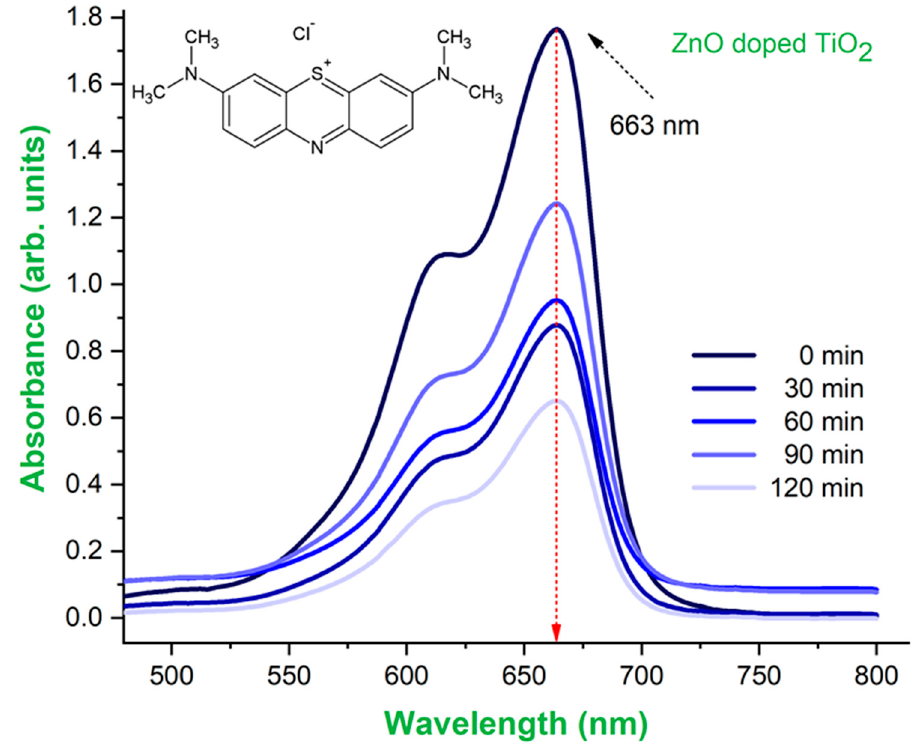
Figure 7. As a result of ZnO-doped TiO 2 nanocomposites, the ultraviolet-visible absorption spectrum of MB is observed.